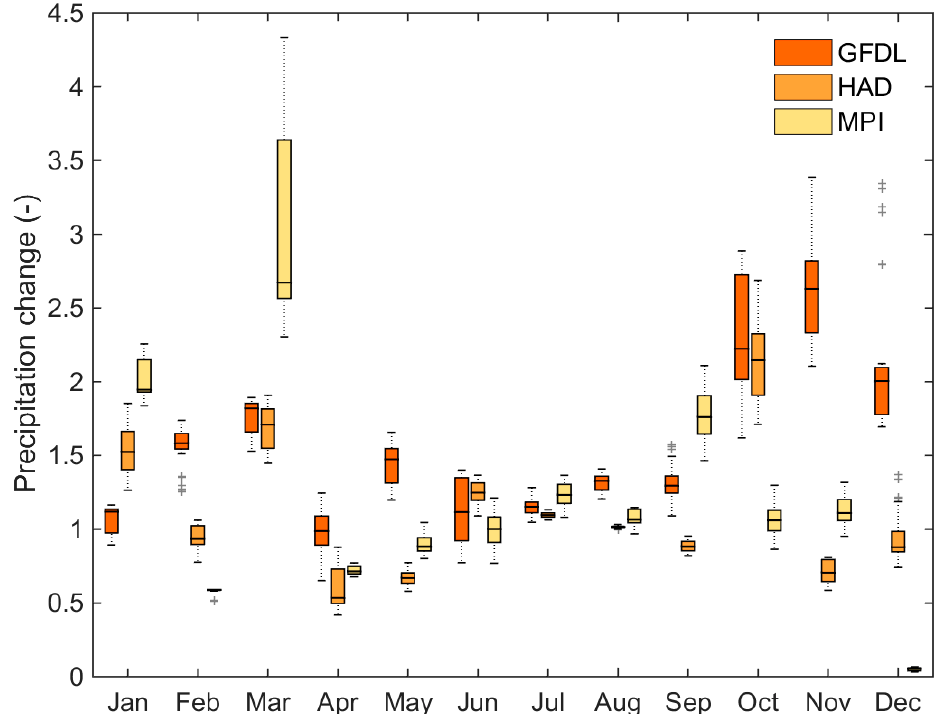
Figure 5. Distribution of change factors (CFs) based on 20-years sampling method at a selected location in middle Awash for the mid-term period (2031–2055) using the three representative models.